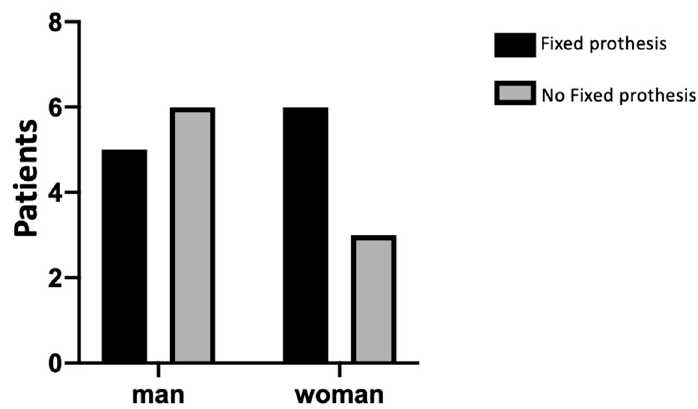
Figure A4. Tooth extraction (EX) carried out between males and females. No statistical significance ( p = 0.15) was shown between the sexes on the tooth extraction performed.